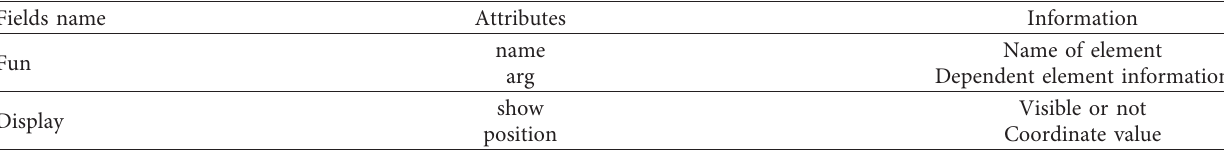
Table 2: Fields and attributes of elements in the r field.